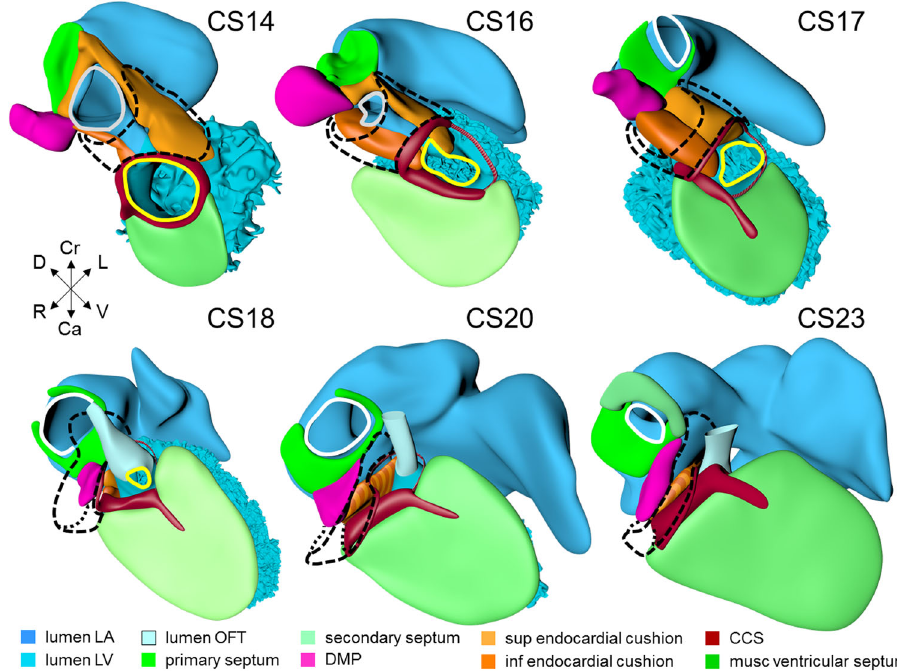
Fig. 4 Pictorial timeline of the closure of the interatrial & interventricular foramens. The panels show right ventral views of the left side of the heart. The left atrial and ventricular cavities, the muscular atrial and ventricular septums, the endocardial cushions, the dorsal mesenchymal protrusion, the secondary atrial septum (CS23 only), and the GlN-positive ring bundle are shown. The superior and inferior endocardial cushions, including their atrial extensions, fuse at CS17. This fusion closes the primary atrial foramen and is accompanied by the appearance of a very wide secondary atrial foramen. The dorsal mesenchymal protrusion acquires a position at the base of the atrial septum due to the expansion of surrounding structures. The protrusion muscularizes, along with the mesenchymal cap, starting at CS18, and concomitant with the proximal endocardial ridges of the out fl ow tract. The borders of the interventricular foramen remodel as revealed by the course of the GlN-positive ring. As soon as septation of the out fl ow tract is complete at CS18, the myocardialized part of the fused endocardial ridges and the rightward margins of the atrioventricular endocardial cushions combine to decrease the size of the remaining foramen. The closure is complete at CS20. Gray contours: primary atrial foramen; white contours: secondary atrial foramen; yellow contours: interventricular foramen. All images are also available as preset views in the corresponding